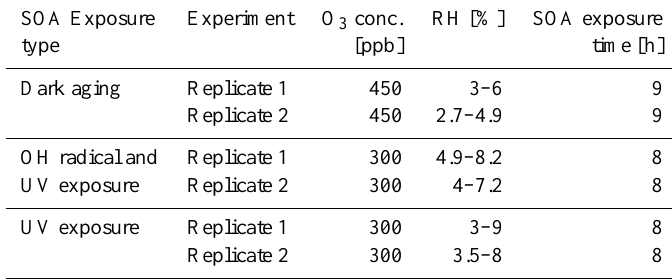
Table 1. Experimental conditions at CESAM chamber. SOA Exposure Experiment O 3 conc. RH [%] SOA exposure type [ppb] time [h] Dark aging Replicate 1 OH radical